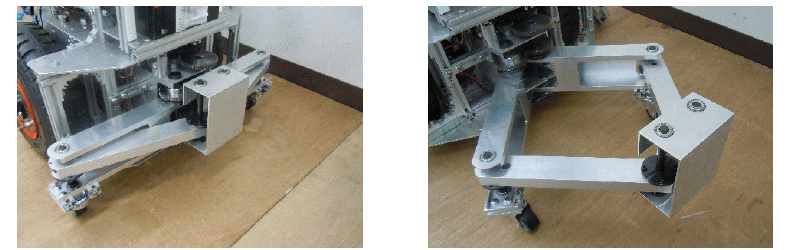
Figure 4. Human method of pushing a hand cart up a step Figure 5. Extendable robot front-wheel mechanism